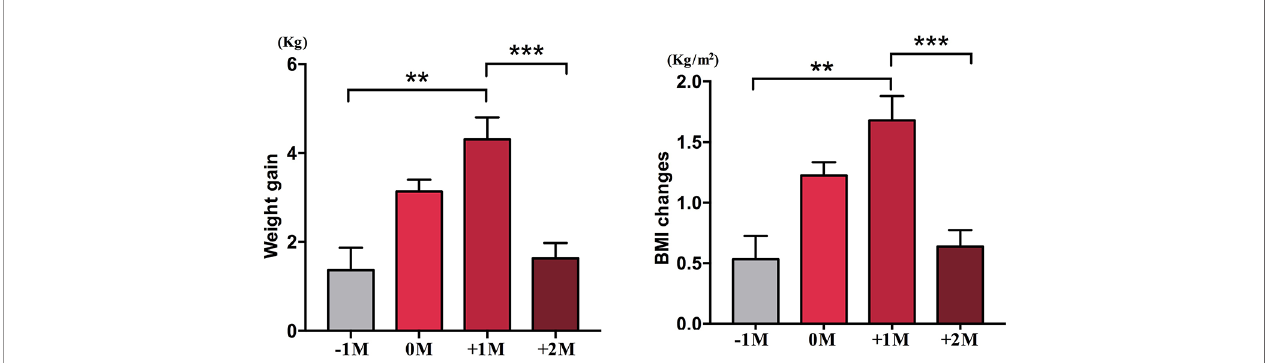
FIGURE 3 | Mean weight gain velocity in increased appetite group. The mean weight gain for each patient per month during the study period was analyzed at four time points: before the month of time to increased appetite ( − 1M), the month of time to increased appetite (0M), 1 month after the month of time to increased appetite increase (+1M), and 2 months after the month of time to increased appetite (+2M). ** indicates P < 0.01, *** indicates P < 0.001.